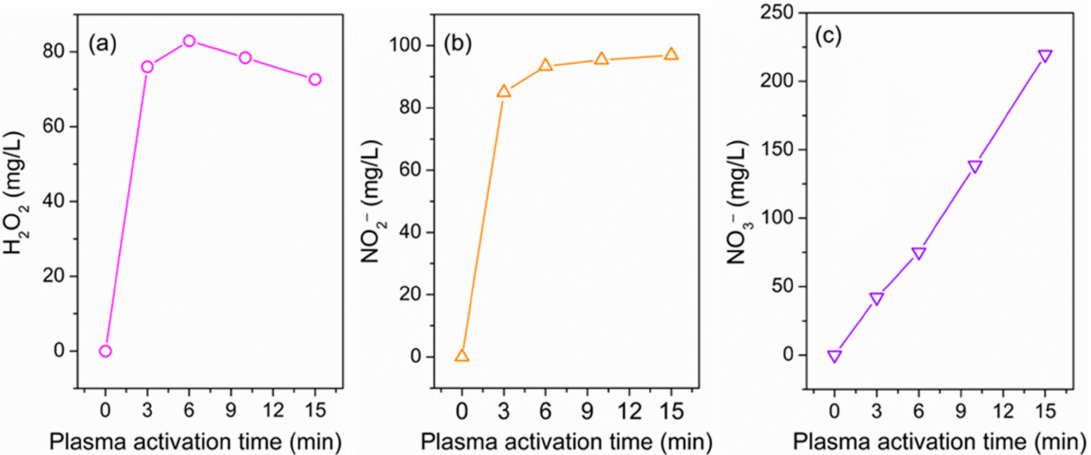
Figure 9. The contents of H 2 O 2 ( a ), NO 2 − ( b ) and NO 3 − ( c ) in PA-AEW accompanied by plasma activation time.